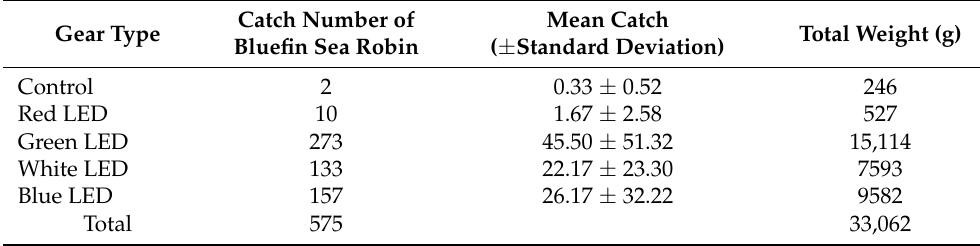
Table 2. Total catches of bluefin sea robin over the experimental period; May–December 2020.